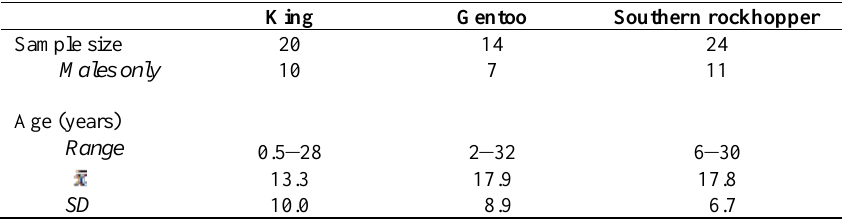
Sample Characteristics for a Mixed-Species Penguin Colony at the Saint Louis Zoo King Gentoo Southern rockhopper Sample